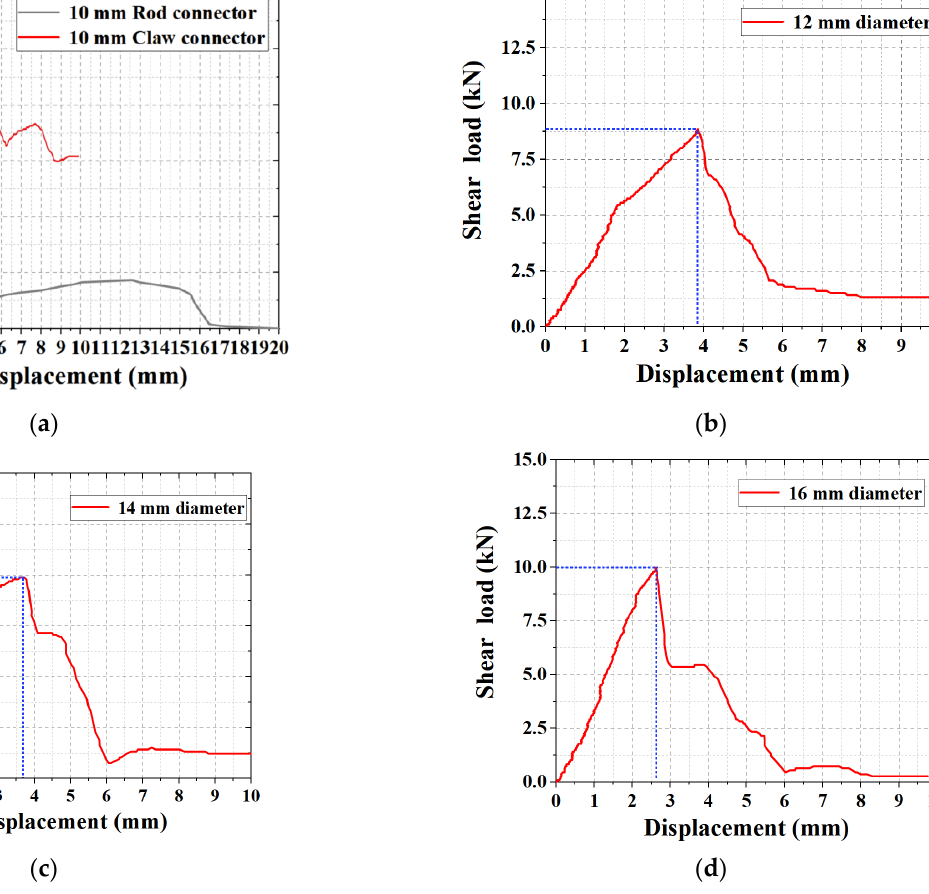
Figure 10. Load–displacement curves of the shear test: ( a ) Comparison of rod and claw connectors. Shear strengths of claw connectors of ( b ) 12 mm outer diameter; ( c ) 14 mm outer diameter; ( d ) 15 mm outer